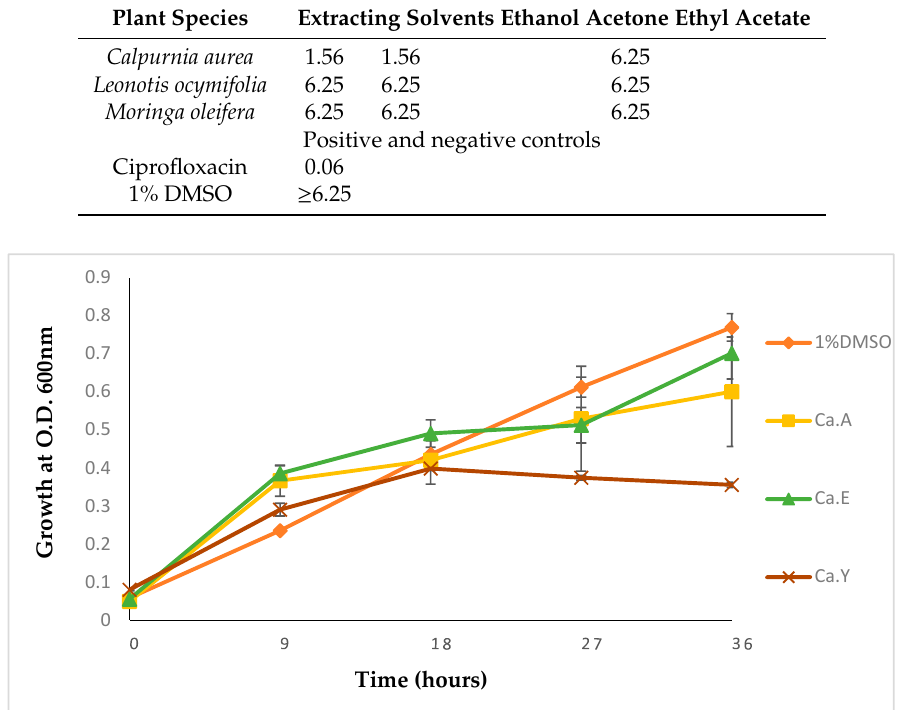
Figure 1. Growth kinetics of Pseudomonas aeruginosa ATCC 9721, 1% DMSO-treated, and treatments with di ff erent Calpurnia aurea extracts prepared at 1 mg / mL incubated at 37 ◦ C for 36 h. The experiments were in triplicates and values presented are means ± standard deviation. Ca.A, Ca.E, Ca.Y—Ca